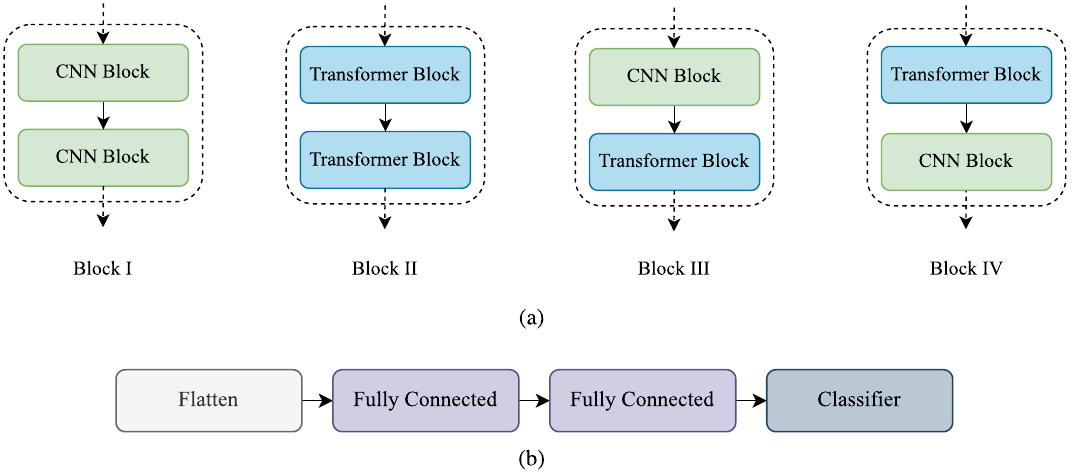
Figure 4. The main parts of models’ structure: ( a ) the backbone block diagrams and b the classification head of